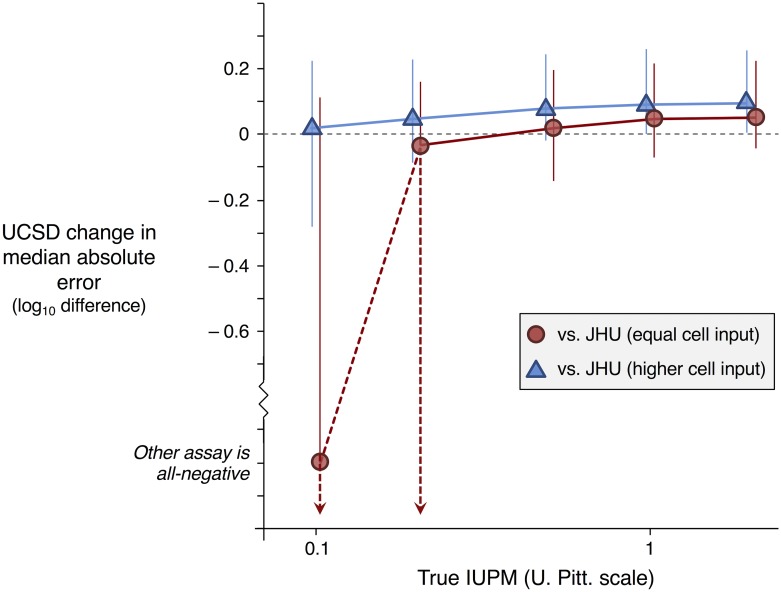
Difference in accuracy between UCSD and JHU assays, assuming that the JHU assay is a gold standard (not subject to lab-based random effect).Batch variation-free ensemble estimates of parameters were used in simulations. Median estimate and 95% credible intervals shown for 0.1, 0.2, 0.5, 1, and 2 IUPM on the U. Pitt. scale. All values plotted are also provided in S14 and S15 Tables.